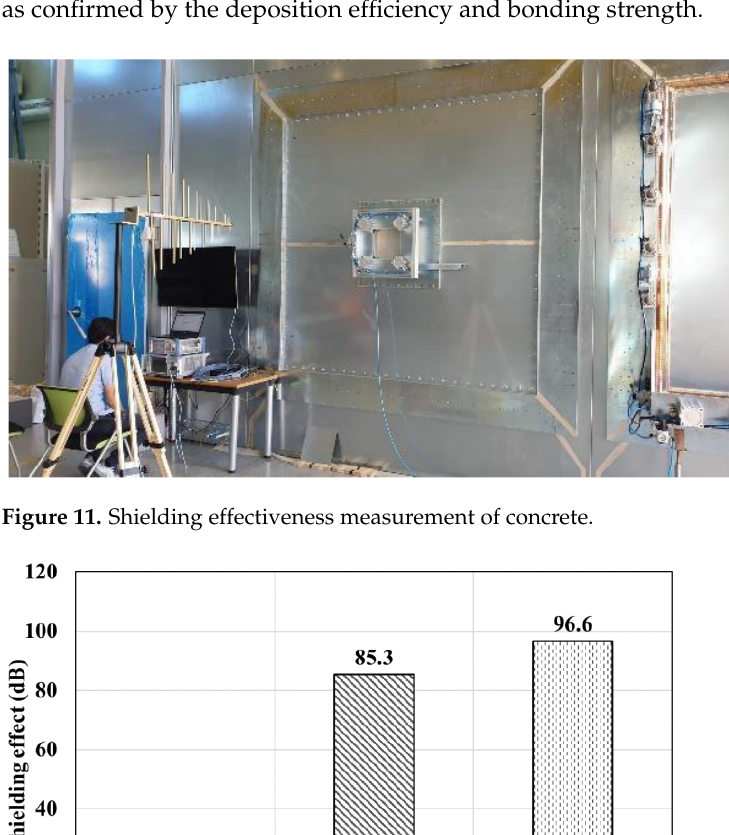
Figure 11. Shielding effectiveness measurement of concrete.